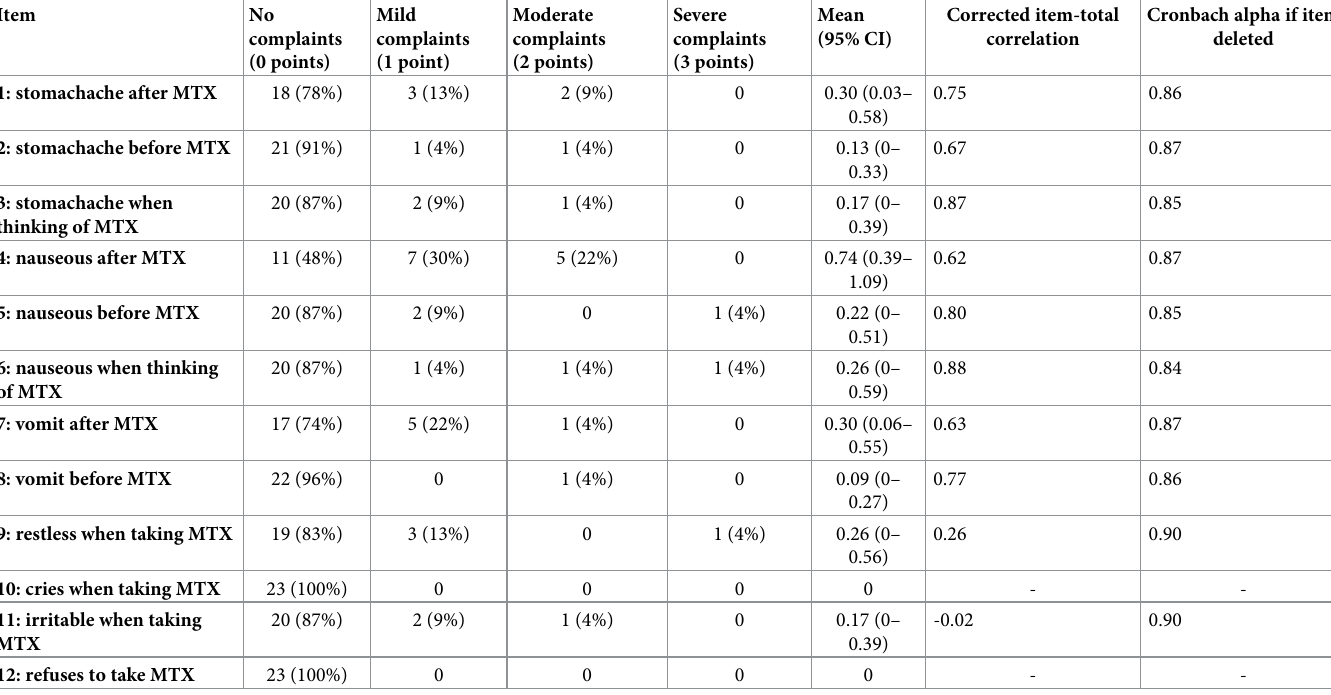
Table 5. The internal consistency of the methotrexate intolerance severity score–the acute lymphoblastic leukaemia group.